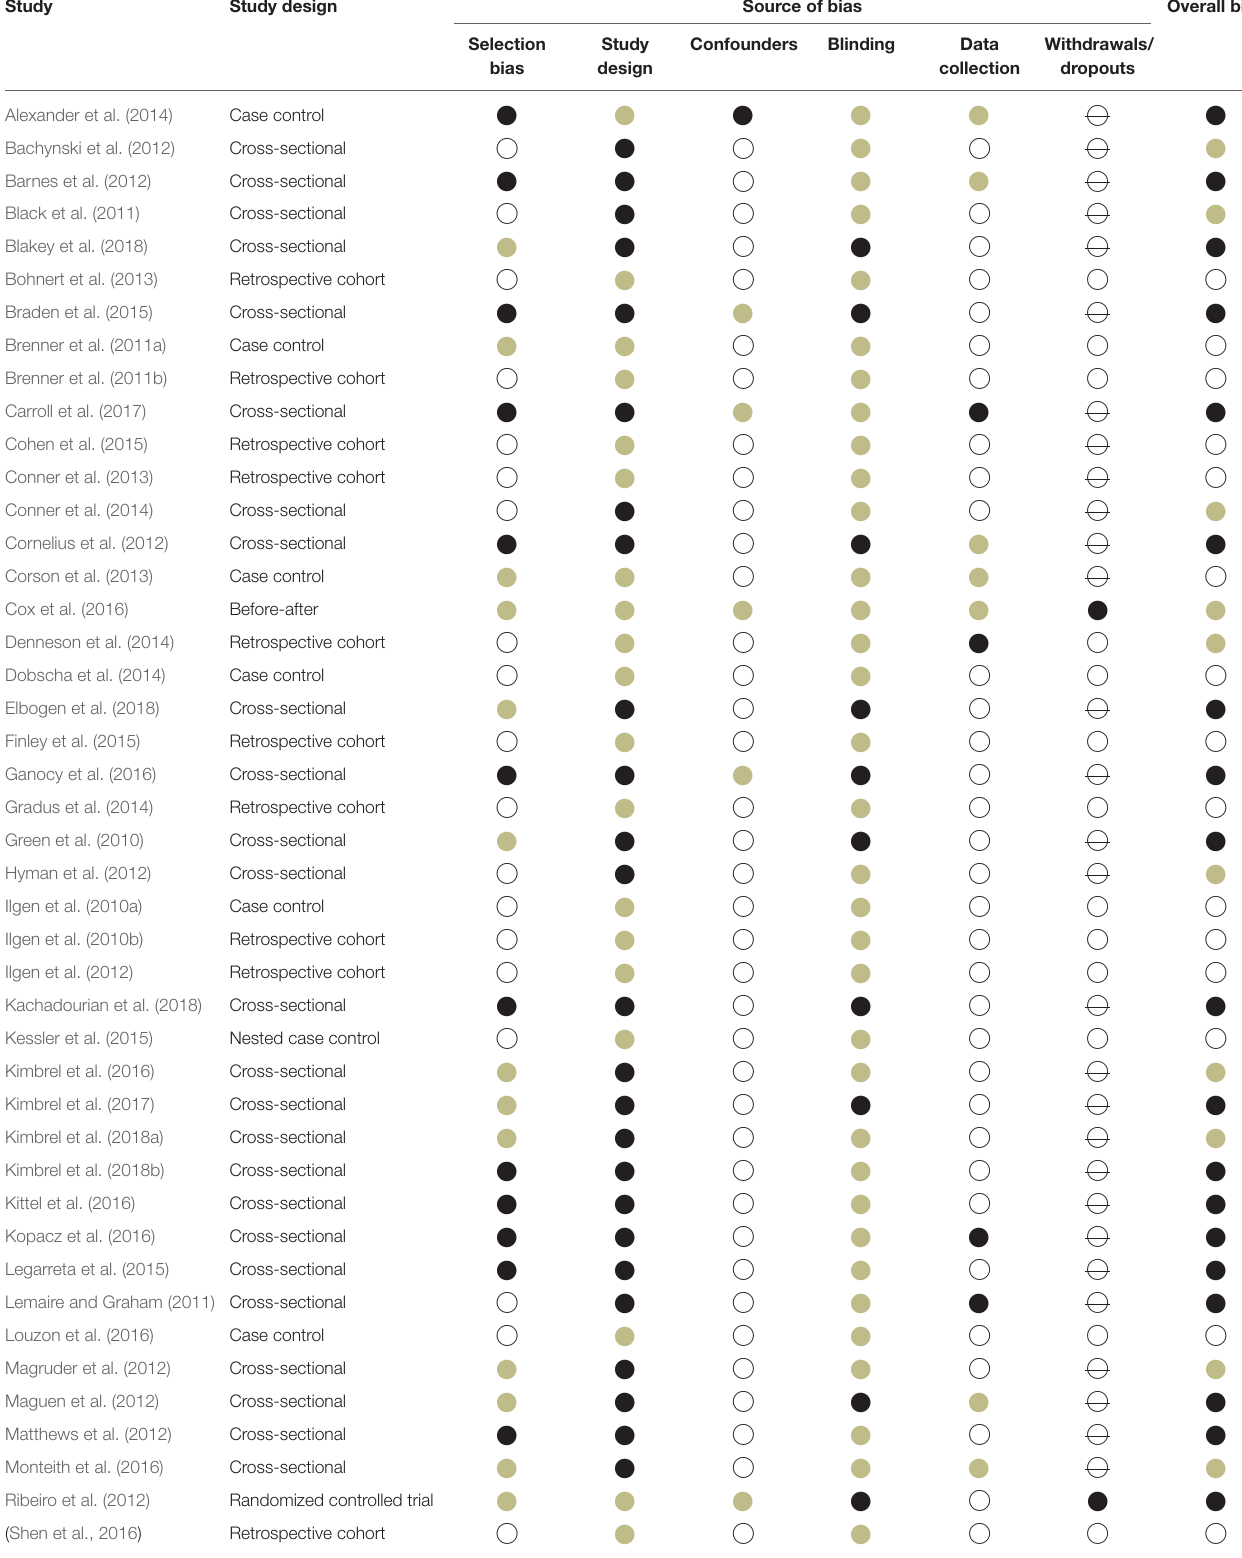
TABLE 1 | Risk of bias ratings for each study ( N =